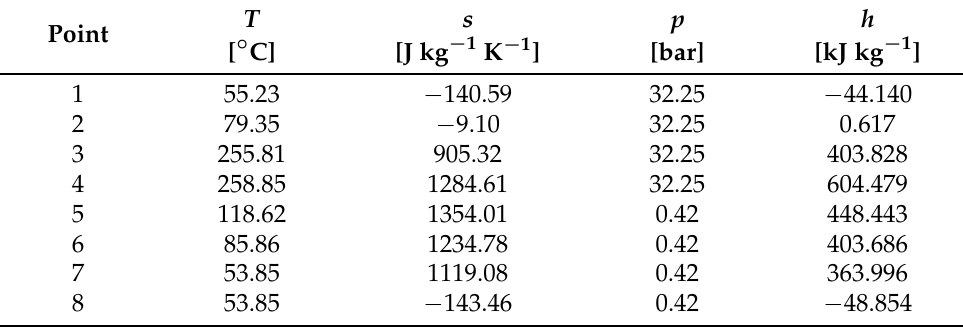
Table 10. Calculated points of Benzene for the ORC